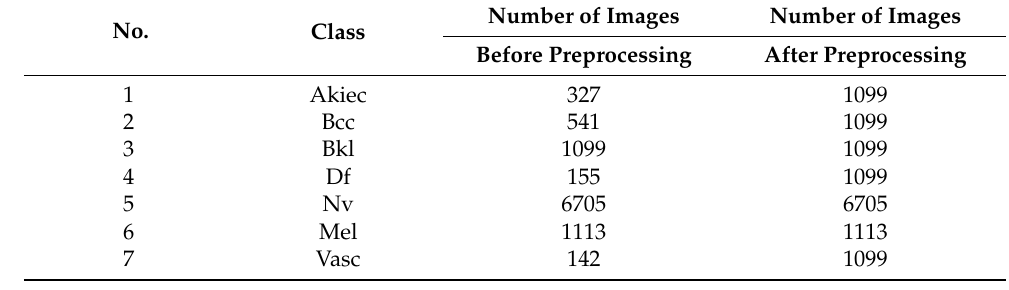
Table 1. Number of images for each class before and after the preprocessing stage.